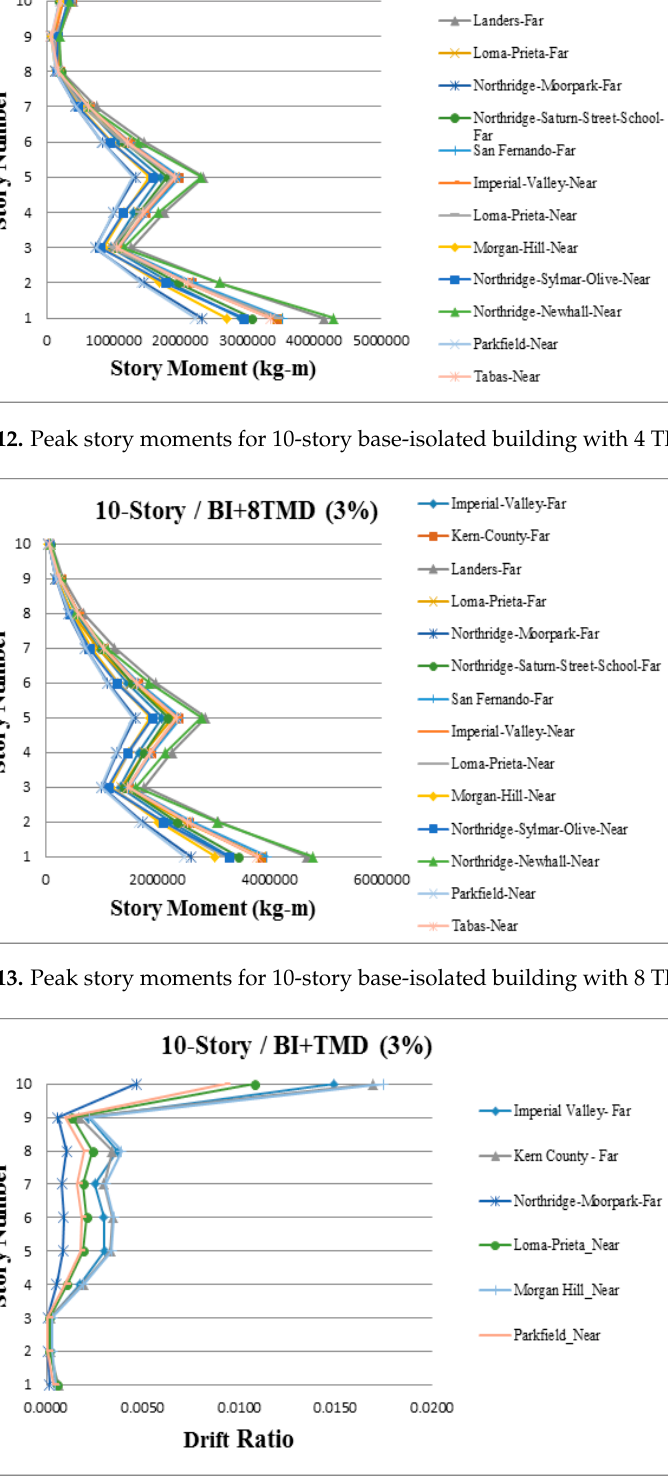
Figure 14. Drift ratios for 10-story base-isolated building with 1 TMD.